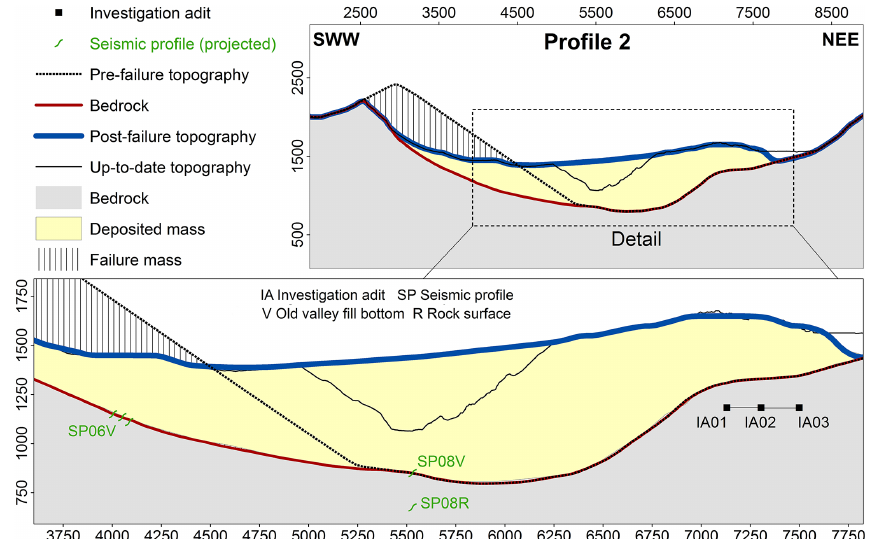
Figure 5. Profile 2 (see Figs. 2 and 3) through the Köfels site with the three reconstructed stages and the up-to-date topography.